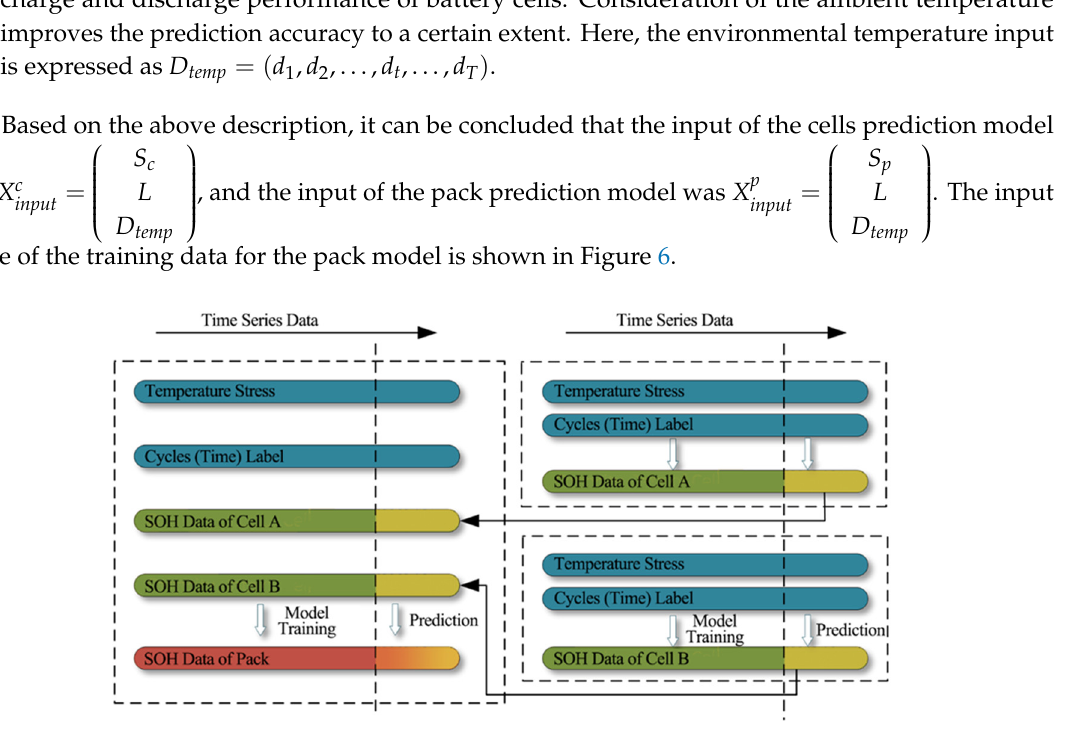
Figure 6. Structure and allocation of input data.